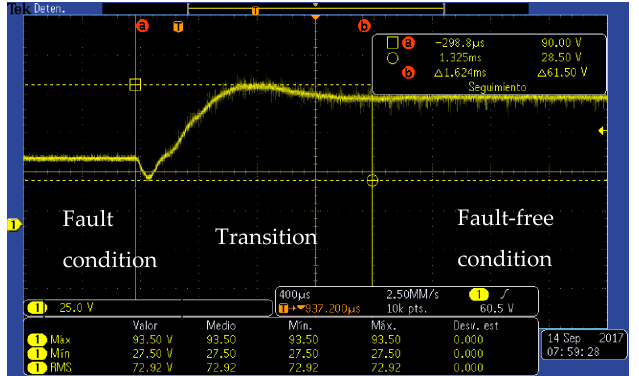
Figure 11. Oscillogram of the transient state of Z-source converter, during its operation change.